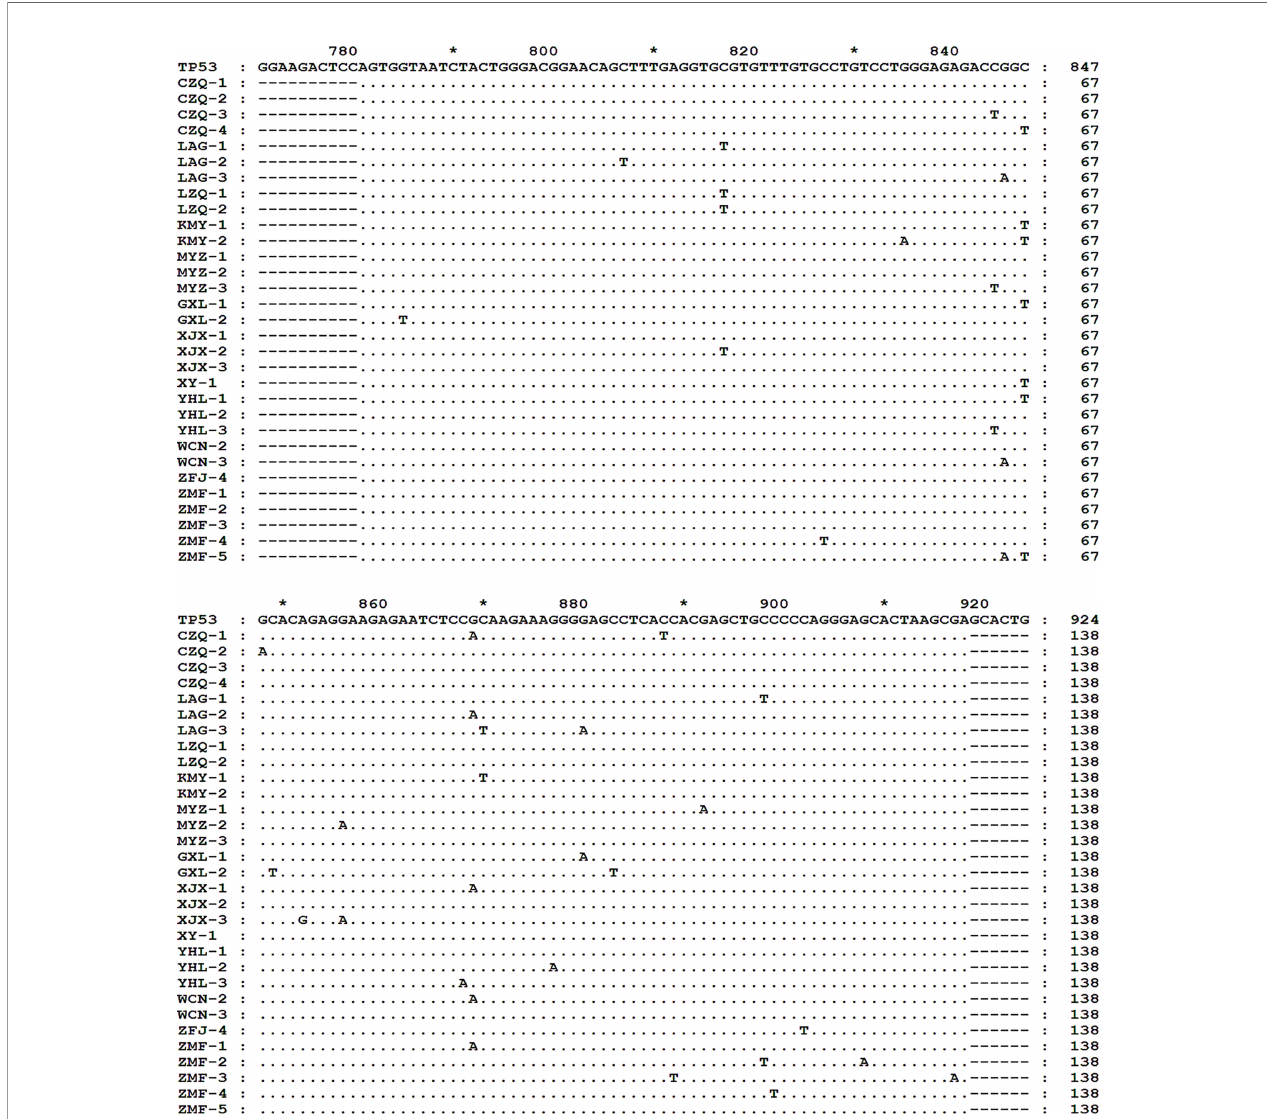
FIGURE 1 | TP53 exon 8 G/C-to-A/T mutations in R/R DLBCL. TP53 exon 8 G/C-to-A/T mutation was detected in R/R DLBCL. Total DNA were extracted from FFPE DLBCL tissues and TP53 exon 8 was ampli fi ed by 3D-PCR and sequenced by Sanger sequencing. Sequences were aligned and analyzed with the Clustal and Genedoc software. * indicates the number in the middle of the two numbers before and